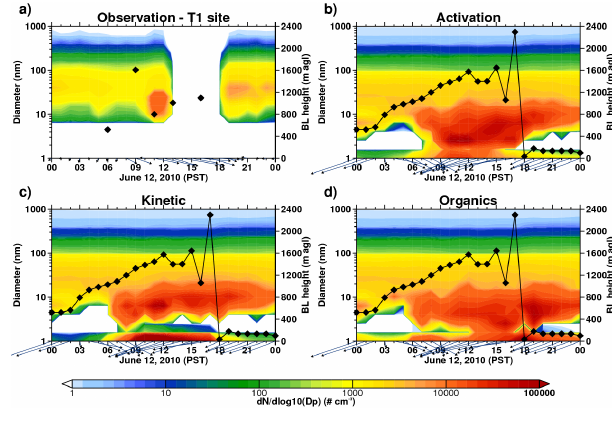
Figure 14. Same as Fig. 13, except for the T1